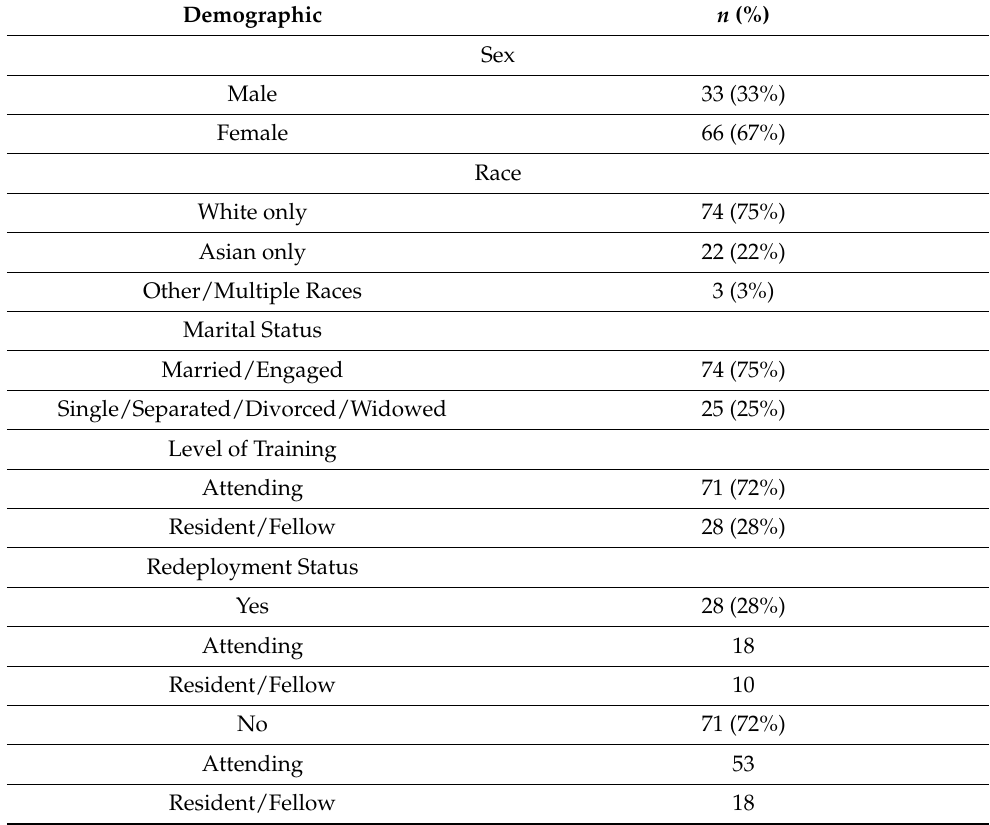
Table 1. Demographics of Pediatric Physician